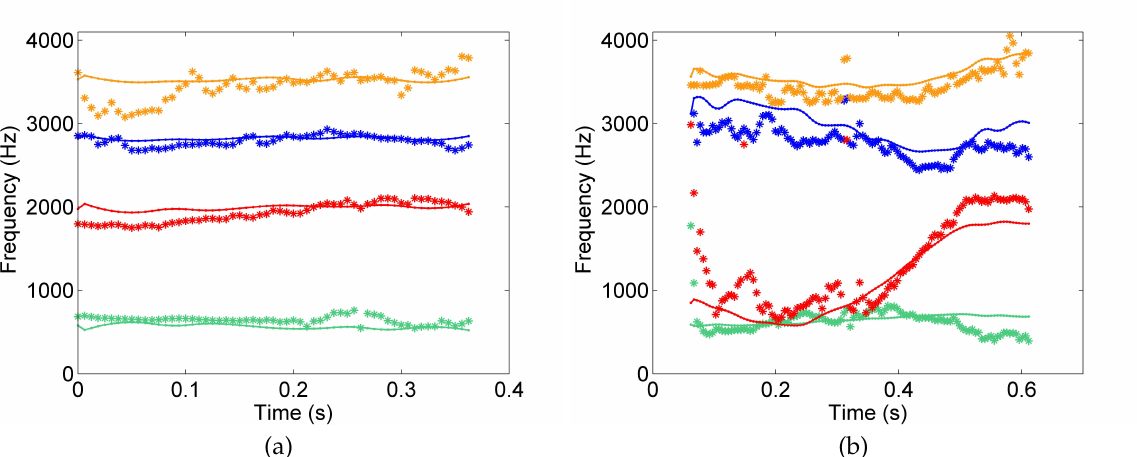
Figure 9. Comparison between the original acoustic formant and the synthesized formant frequency of the English letter and word ( a ) “a” and ( b ) “boy”, respectively. The green, red, blue, and orange “ ∗ ” symbols represent the first, second, third, and fourth original formant frequency, respectively. The green, red, blue, and orange lines represent the first, second, third, and fourth fitted formant frequency,